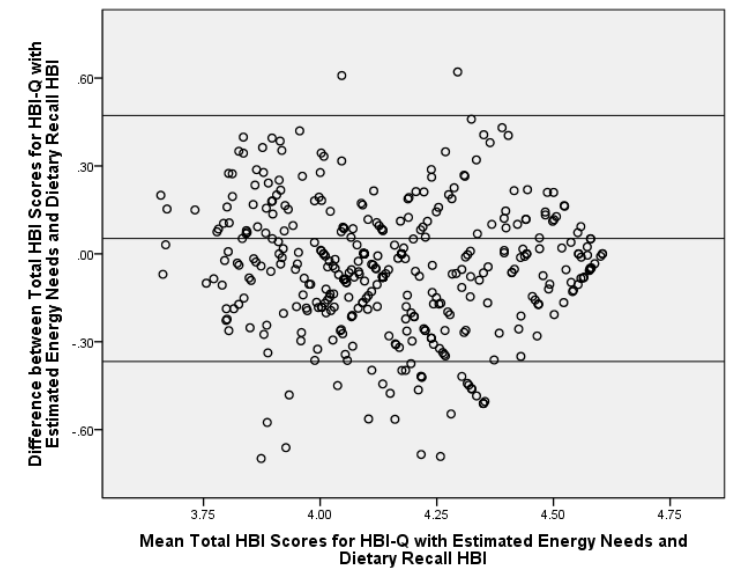
Figure 1. Bland–Altman Analysis of the HBI ‐ Q with Estimated Energy Needs vs. Dietary Recall Healthy Beverage Index (HBI) Scores for Total HBI Scores; Adults ( n = 404) living in Southwest Virginia, United States, 2012–2016. All values are log ‐ transformed. The center line represents the mean difference and the upper and lower lines indicate the mean ± 1.96 × standard deviation. HBI ‐ Q, a method to rapidly determine Healthy Beverage Index scores. Table 4. Comparison of Healthy Beverage Index (HBI) scores from the HBI ‐ Q and dietary recalls ( n = 404).